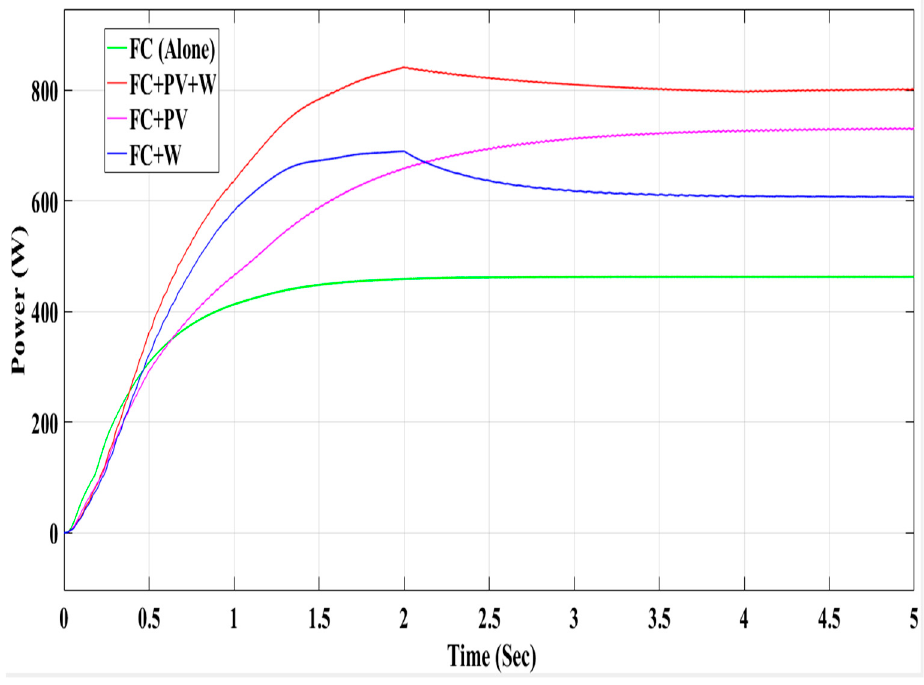
Figure 33. Comparative characteristics of power in the FC, FC–PV, FC–W and FC–PV–W models using a fuzzy logic controller.